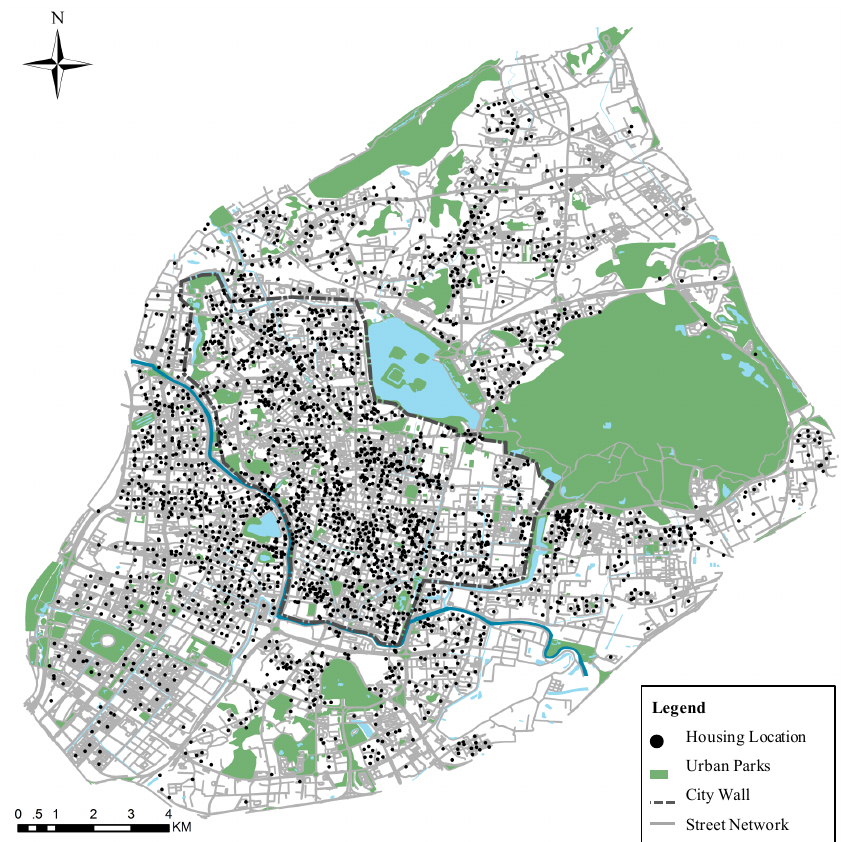
Figure 2. The distribution of parks and housing units in the study area.